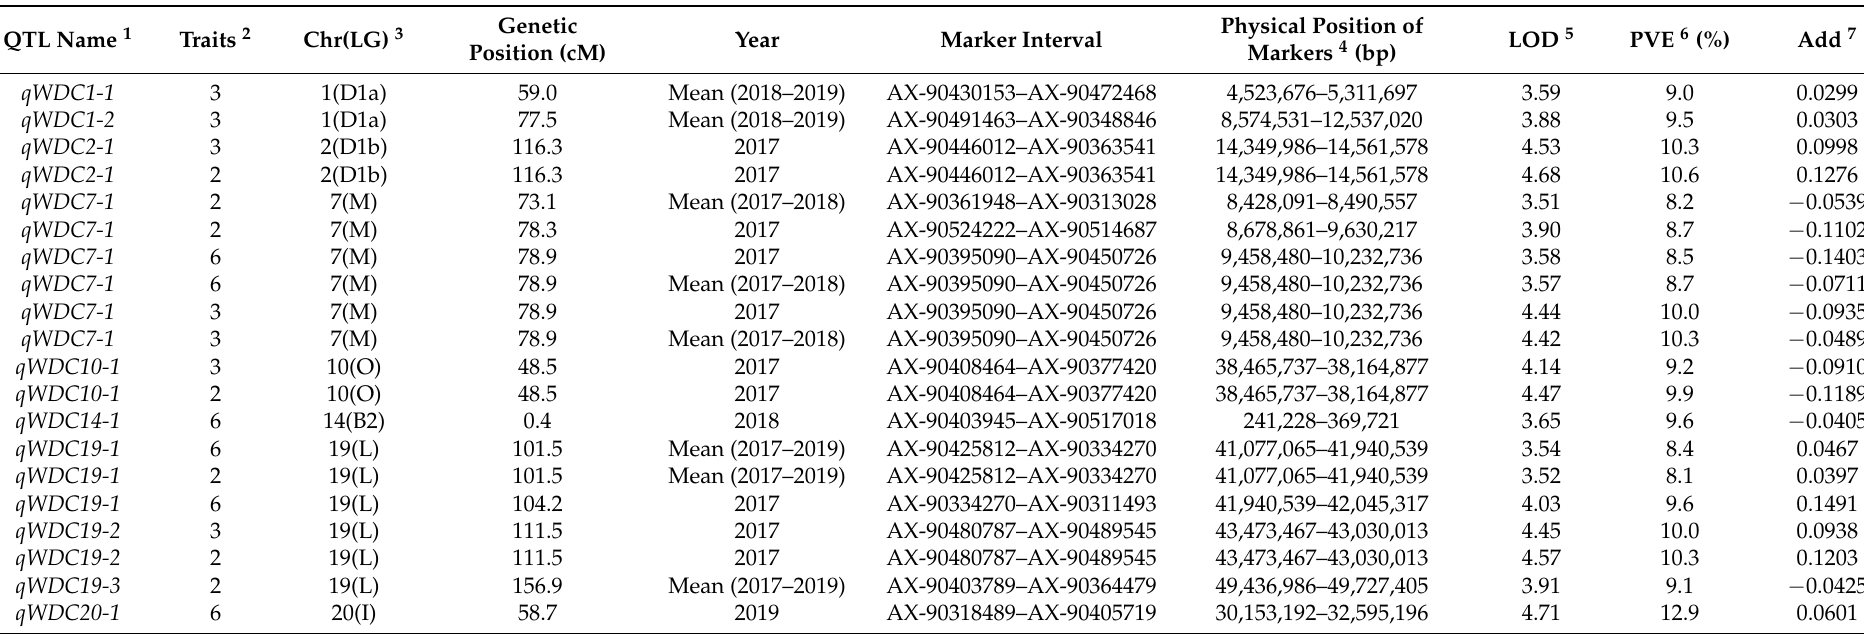
Table 2. QTLs for drought tolerance identified in a recombinant inbred line population derived from a drought-tolerant ‘PI416937’ and susceptible ‘Cheonsang’